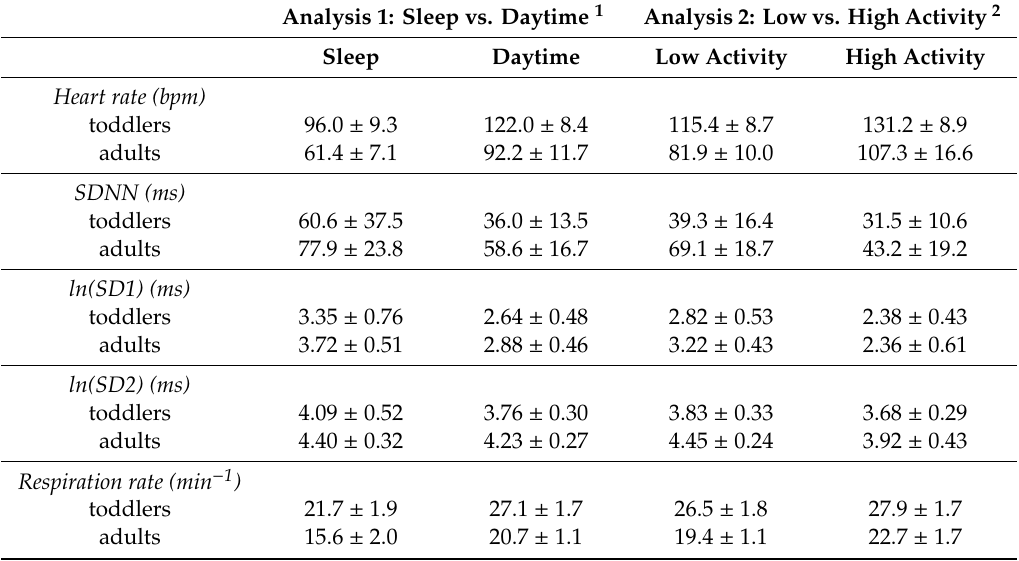
Table 2. Basic cardiac and respiration characteristics in toddlers and adults (mean ±